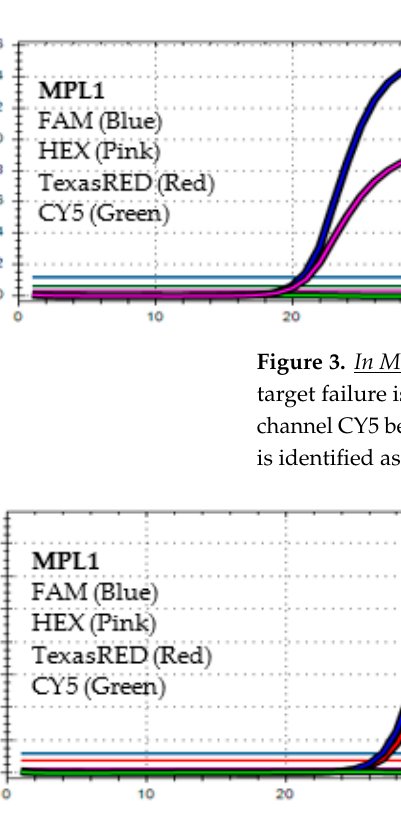
Figure 4. In MPL1 , the target failures are detected in 2 channels, HEX and CY5. In MPL2 , the target failure is detected in channel HEX. This pattern is identified as variant BA.4 .